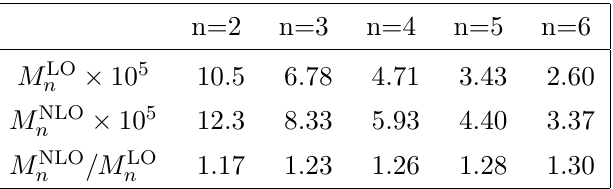
Table 1 . Moments and K -factors for the fragmentation function D c → η µ R = 2 m c .